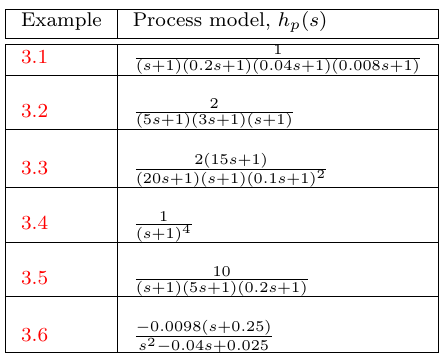
Table 3: Examples and the corresponding linear pro- cess models for Sec.